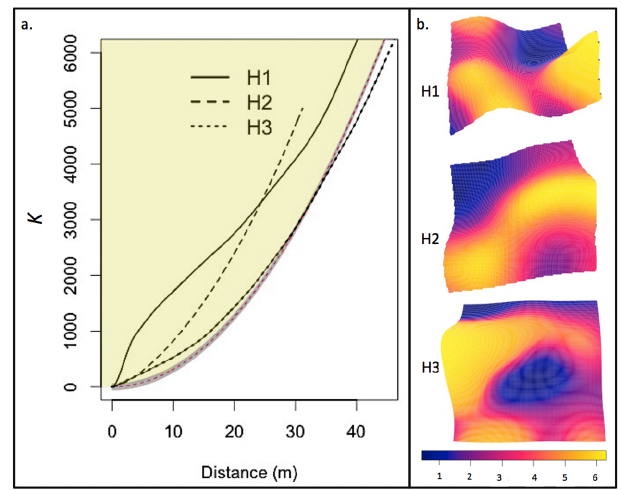
Figure 3. ( a ) Ripley’s K for post ‐ fire conifer regeneration in the Hayman Fire plots (H1, H2, and H3). A clustered point pattern is indicated by an observed K (r) (black lines) that is above the CSR simulated envelope (gray shaded region) and regular spacing is indicated by an observed K (r) that is below the envelope. The clustered region is shown in yellow. Clustering in post ‐ fire conifer regeneration occurred across all distances in H1 and H2 and at distances <30 m in H3. Beyond 30 m regeneration occurred in a regular pattern; ( b ) Perspective plots of post ‐ fire conifer regeneration density (stems m − 2 ) in the Hayman Fire, with density represented by the height and color of the plot.